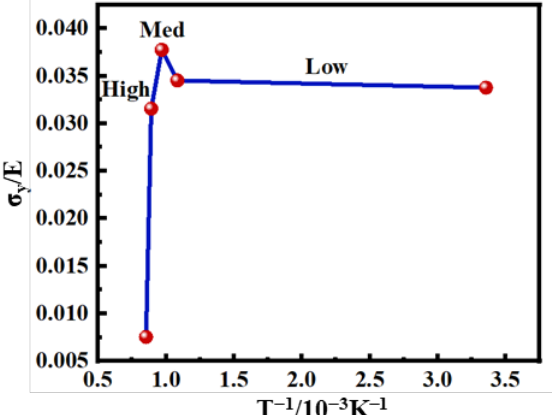
Figure 1. Tensile properties of the superalloy at different temperatures.